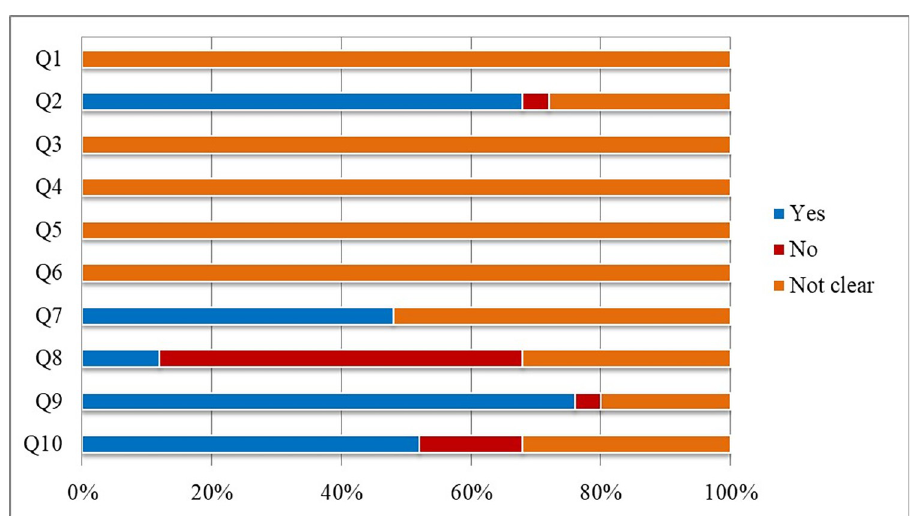
Fig 2. Assessment of the risk of bias of the studies included in the systematic review aiming to answer the question: What are the mechanisms of action of molecules with anti-tnf- α activity on the intestinal barrier? The articles were evaluated based on the tool of the SYstematic Review Center for Laboratory Animal Experimentation (SYRCLE), developed by Hooijmans et al. [16].